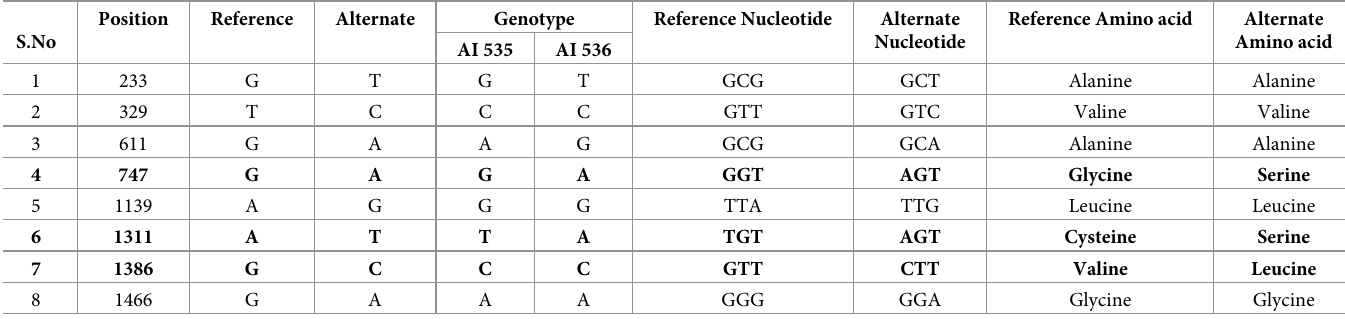
Table 3. Identification of SNPs in fea 2 gene between high and low KRN genotypes.